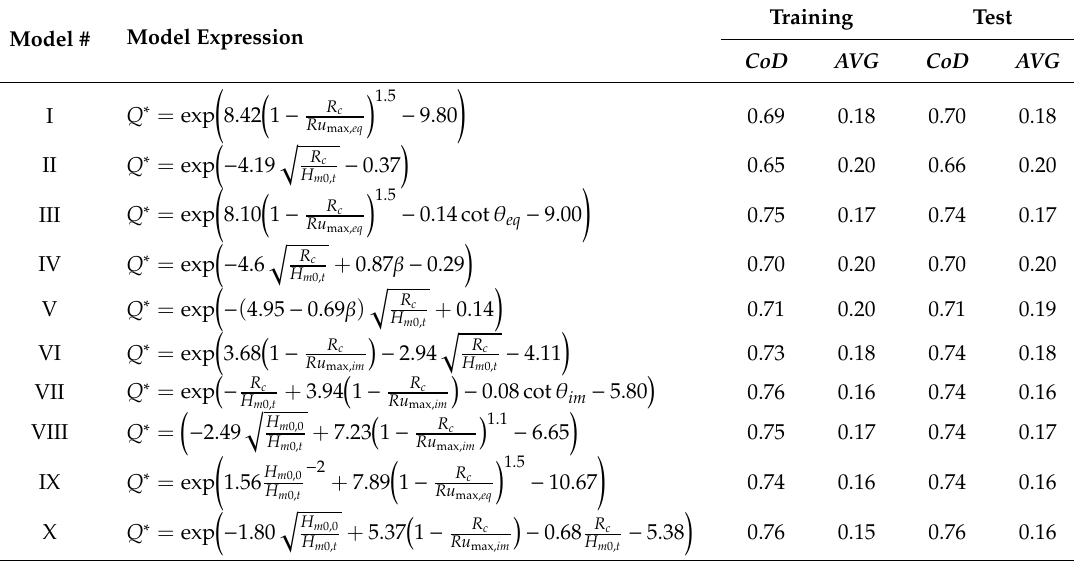
Table 2. Model expressions returned by Evolutionary Polynomial Regression (EPR). AVG : average error, CoD : coe ffi cient of